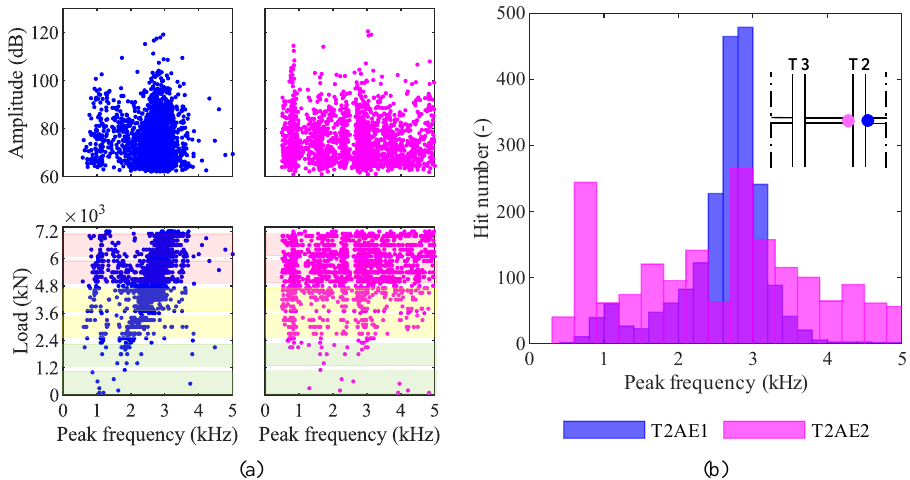
Figure 17. Results in the frequency-domain from the loading phase P4 7200 kN: ( a ) amplitude and load — peak-frequency; ( b ) peak frequency distribution among hits.